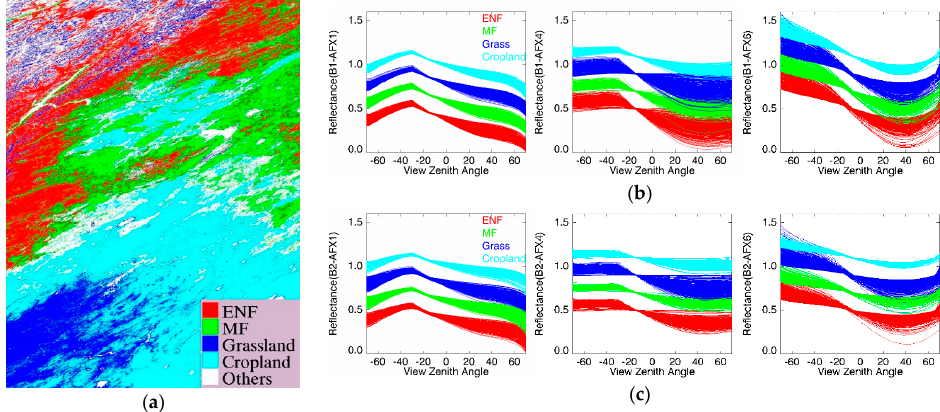
Figure 4. The land cover map of the study area ( a ) and the corresponding normalized BRDF shapes of the red ( b ) and NIR ( c ) bands in the principal plane for ENF ( red lines ), MF ( green lines ), grassland ( blue lines ), and cropland ( cyan lines ).